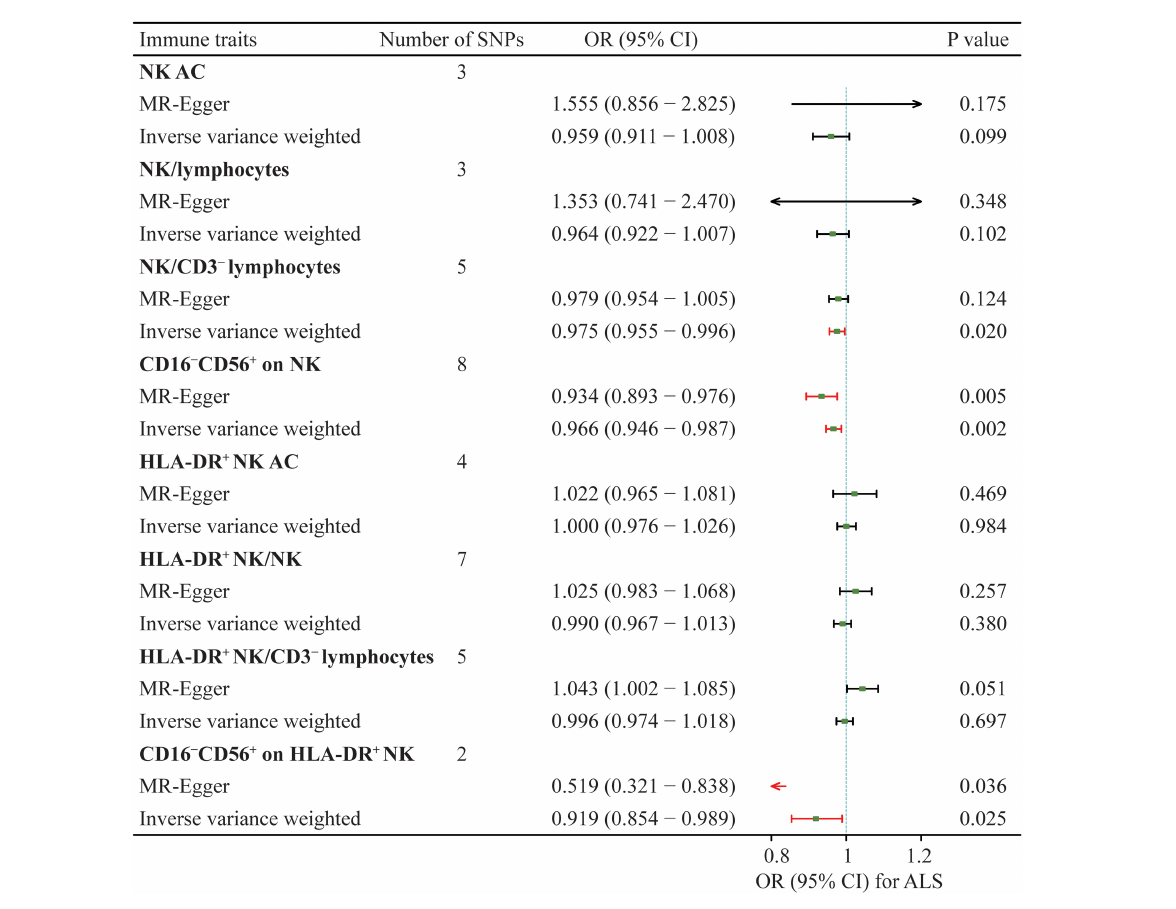
development of ALS (Chiu et al., 2009; Cirulli et al., 2015;